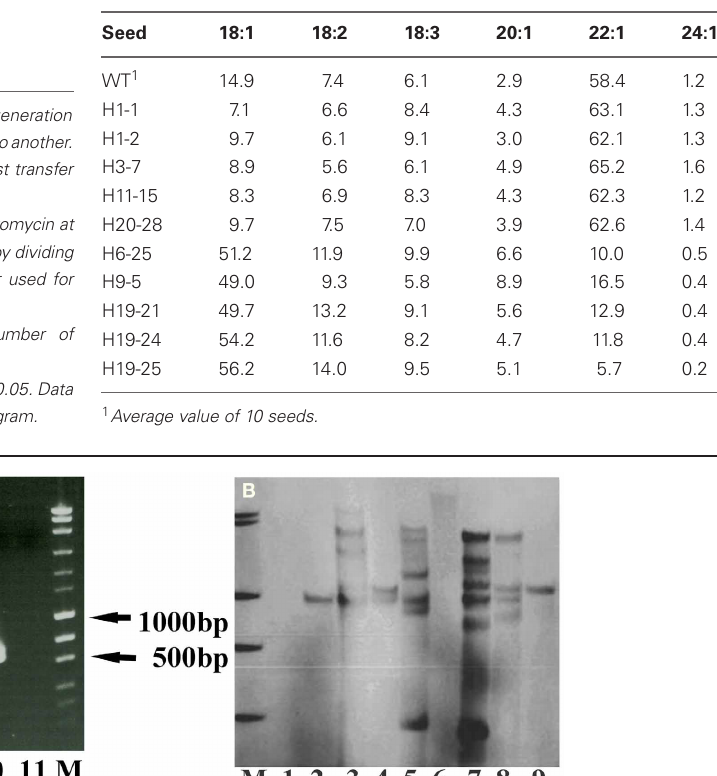
oil of single T1 seeds with either higher 22:1 or 18:1 in transgenic seeds (H) with the LdLPAAT and BnFAE1 genes in comparison with the wild type (WT).